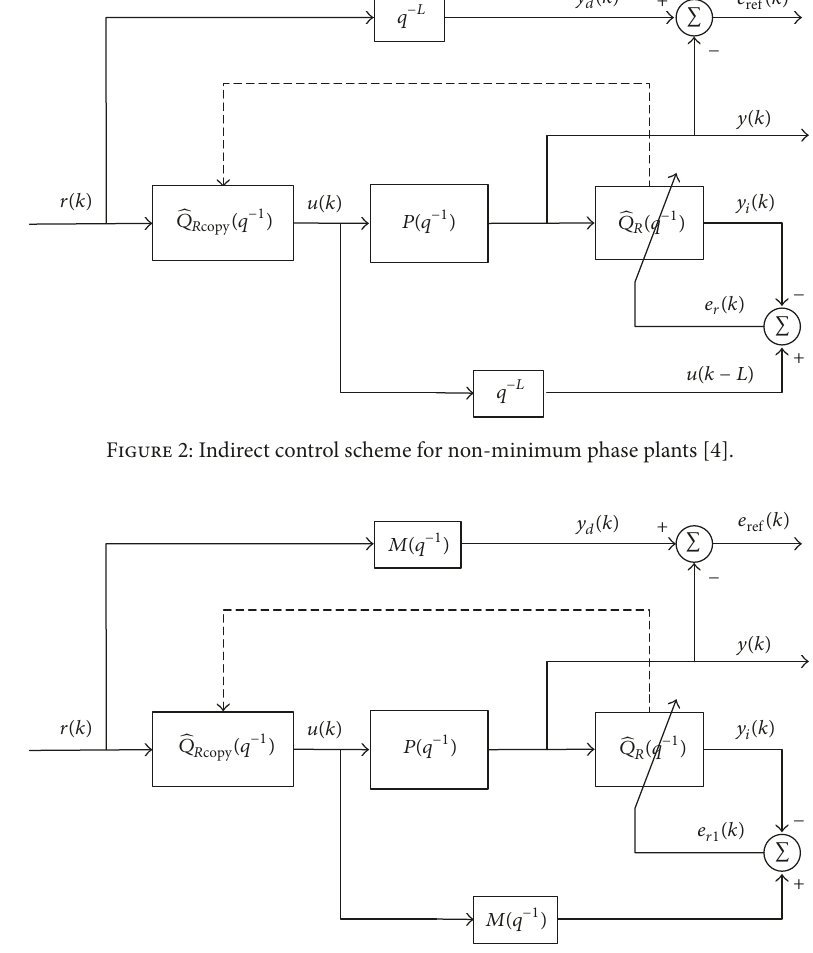
Figure 3: Indirect AIC structure for linear SISO plants